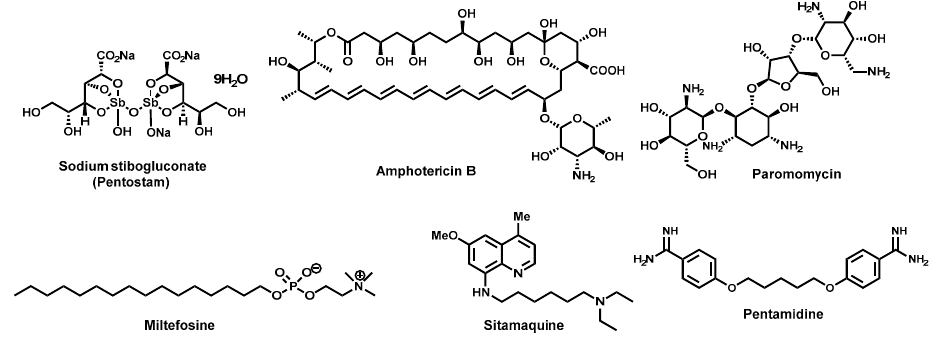
Figure 6. Currently used antileishmanial drugs.